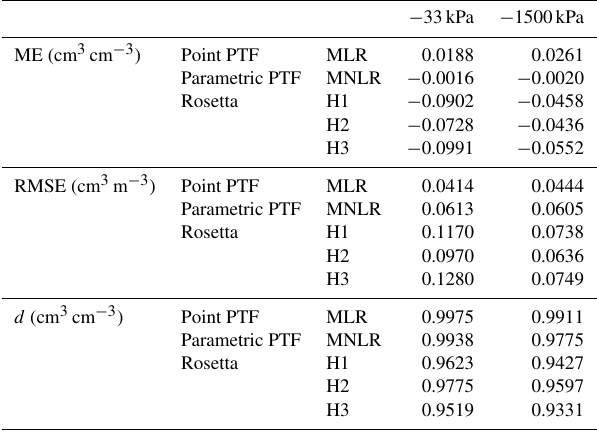
Table 3. Evaluation criteria of water retention pedotransfer func- tions (PTFs) at − 33 and −